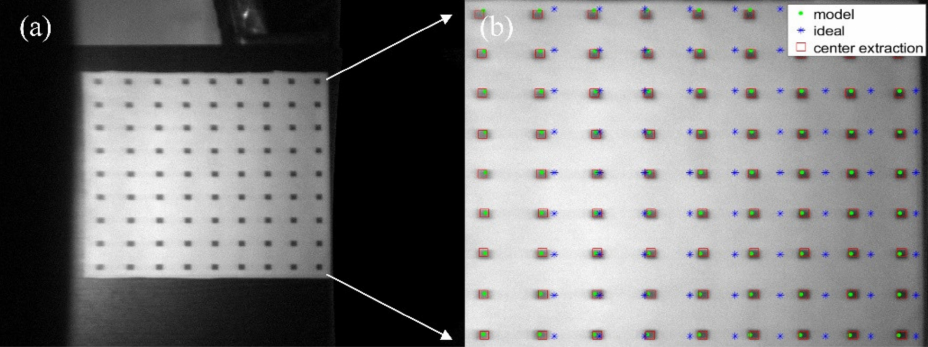
Figure 13. The experiment of the square target: ( a ) actual image of diffracted light at a polar angle of − 7 ◦ ; ( b ) the partially enlarged view of the square